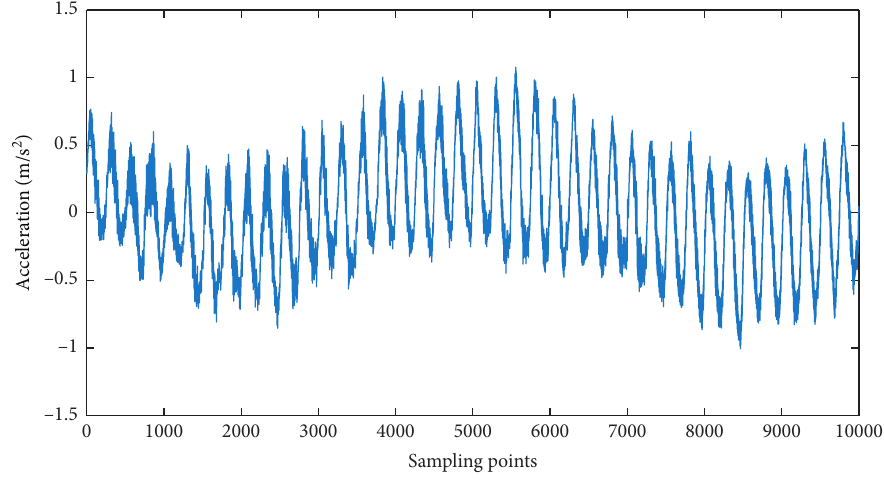
Figure 10: Sampling points of